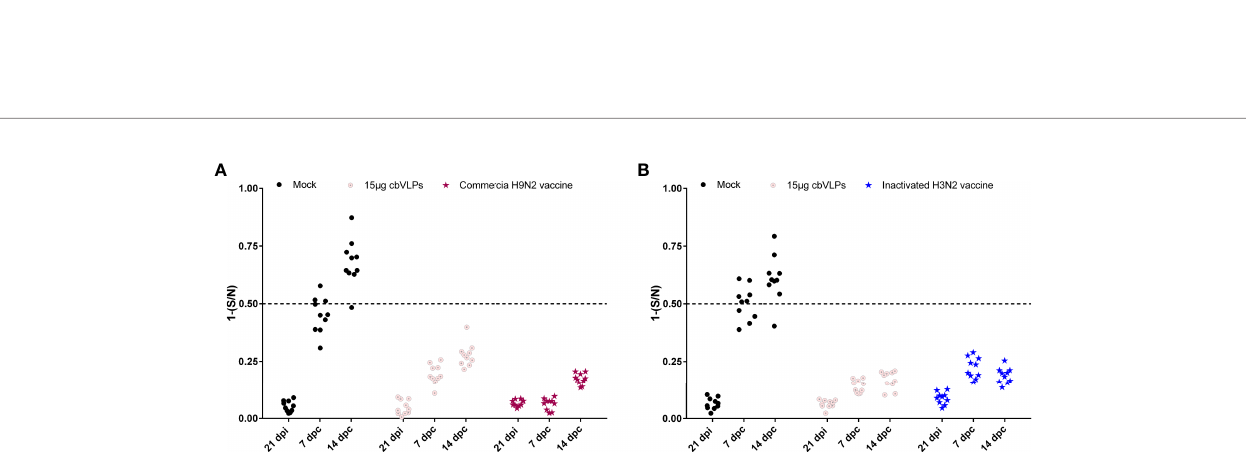
FIGURE 8 | Differentiation of vaccinated chickens from infected chickens. Ten serum samples were collected on 21 days post immunization and on 7 and 14 days post challenge. The levels of serum antibody against the nucleoprotein (NP) of IAVs were tested with a commercially available NP-cELISA kit. Each dot represents the NP-speci fi c antibody value of each chicken. Panel (A) : The immunization groups post challenge with H9N2 AIV; Panel (B) : The immunization groups post challenge with H3N2 AIV. Signi fi cance of difference was compared between cbVLPs and commercial H9N2 vaccine or inactivated H3N2 vaccine by a Two-Way ANOVA test. dpi, day post immunization; dpc, day post